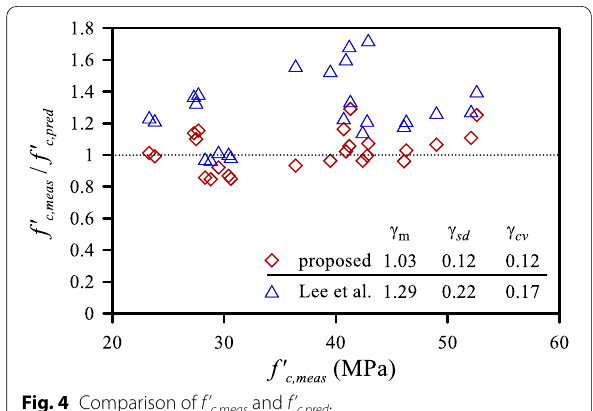
Fig. 4 Comparison of f’ c,meas and f’ c,pred .